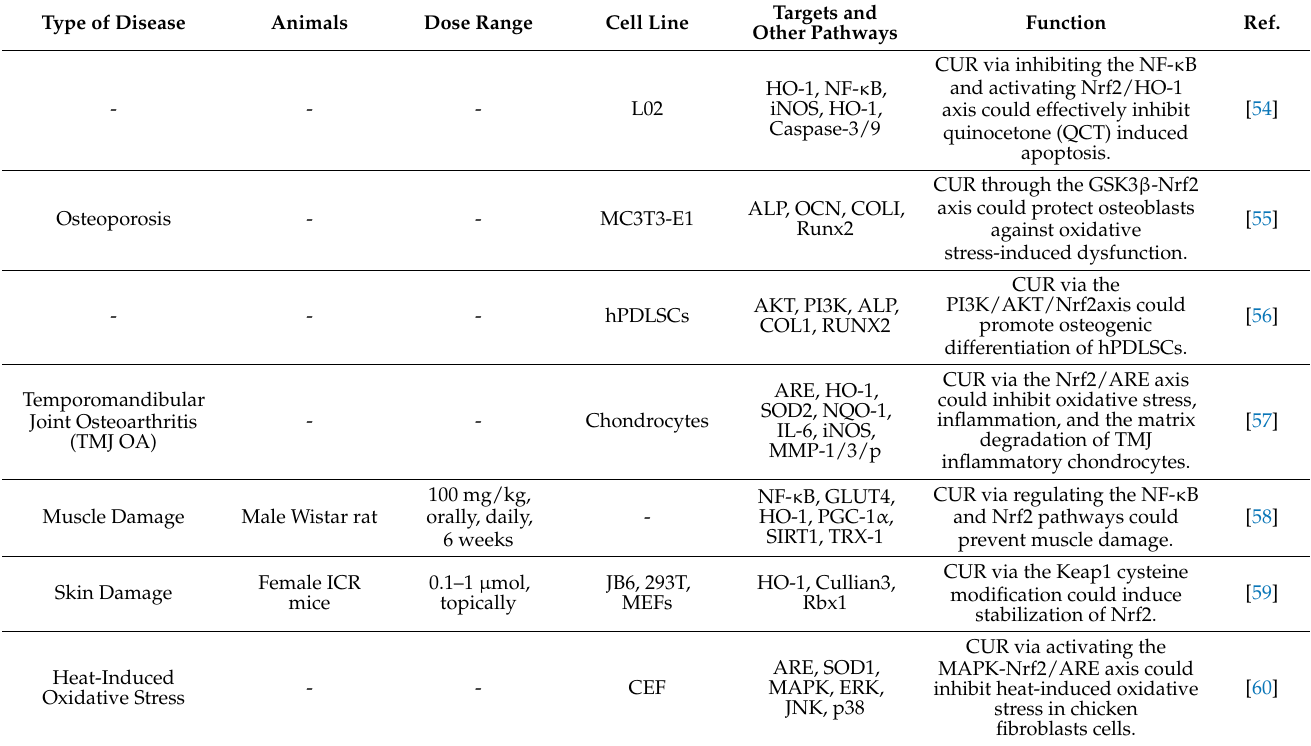
Table 7. Nrf2-related therapeutic effects of curcumin in other